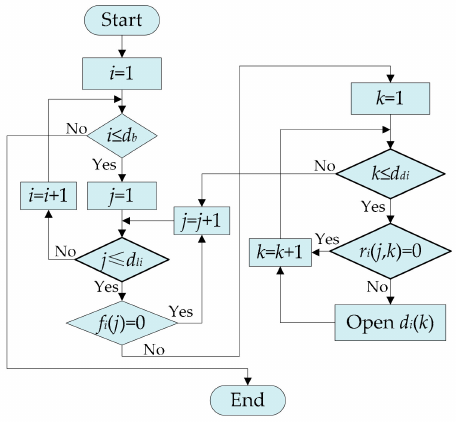
Figure 6. The algorithm for faulted feeder section